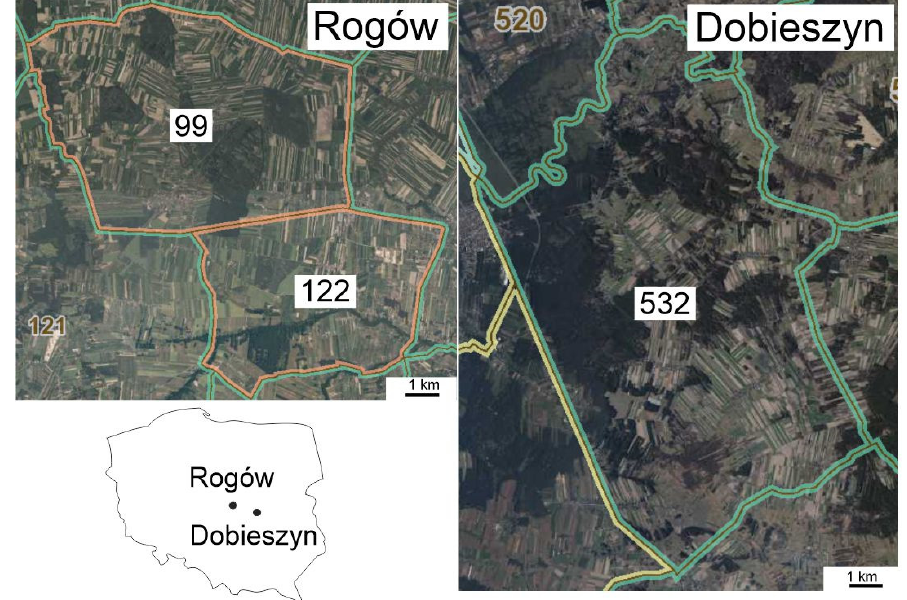
Figure 1. The two study areas are located in central Poland: Rogów (the focus area) and Dobieszyn (a reference area). The studies were carried out in the areas of hunting units no 99 and 122 (Rogów), and 532 (Dobieszyn), with their borders marked in orange (Rogów) and green (Dobieszyn). Source of the maps [41].